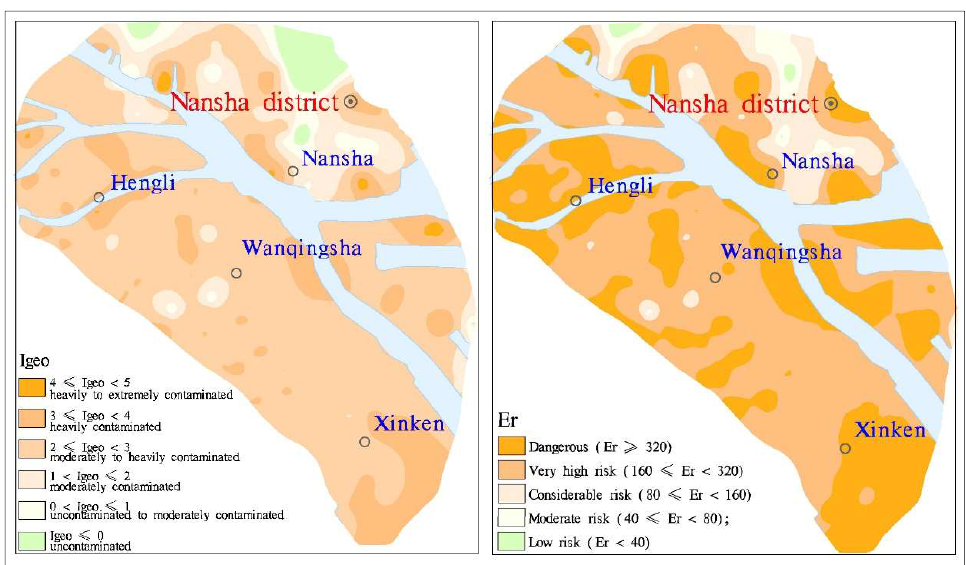
Figure 8. Soil Cd evaluation using the Geological Accumulation Index ( left ) and the Potential Ecological Risk Index ( right ) in Nansha District.